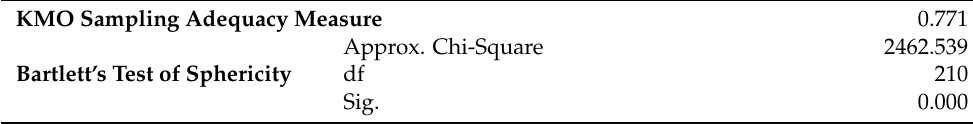
Table 2. KMO and Bartlett’s Test of the Barriers to the adoption of 4IR